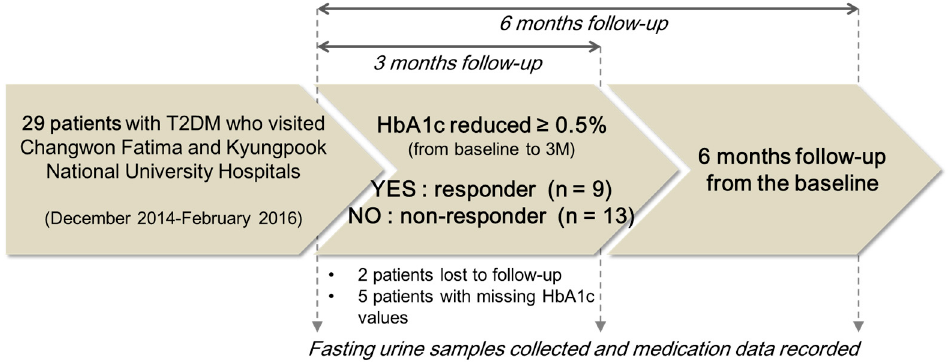
Figure 4. Characteristics of the study subjects.